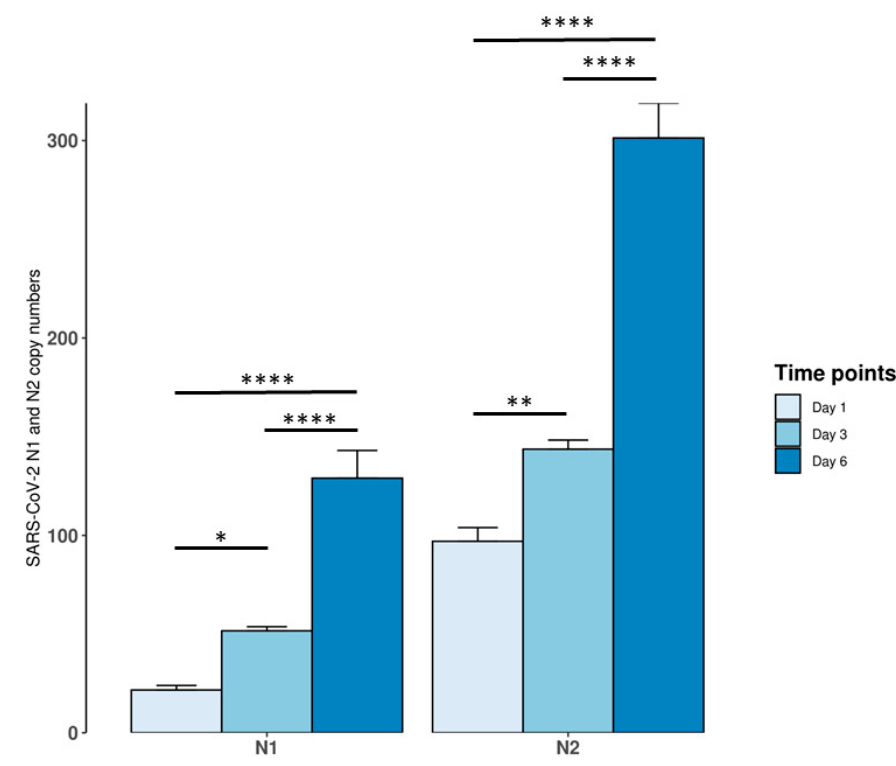
Figure 1. Virus replication in HCN-2 cortical neurons. N1 and N2 copy number increased in a time dependent manner. * p < 0.05; ** p < 0.01; **** p < 0.0001.